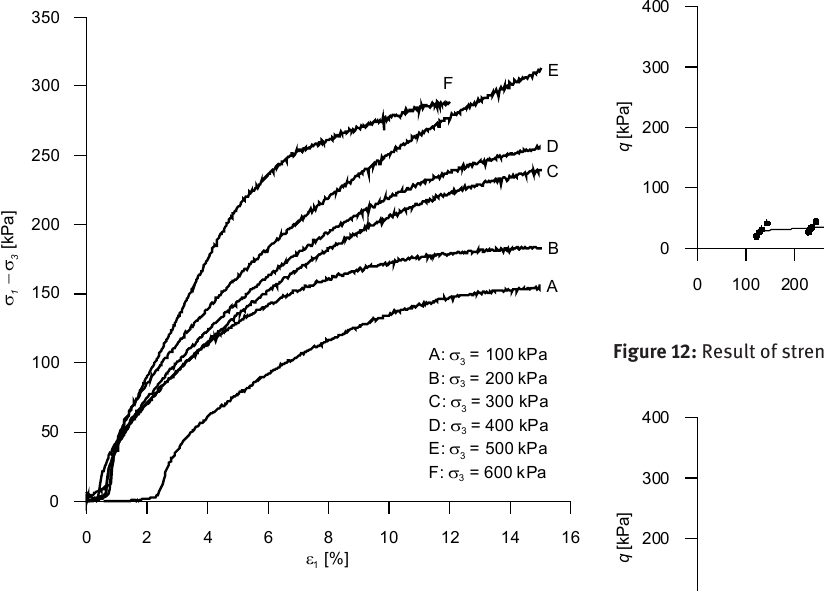
Figure 10: Illustration of the results of strength tests of soil of stiff consistency (A-3 and B-3) from one sample.